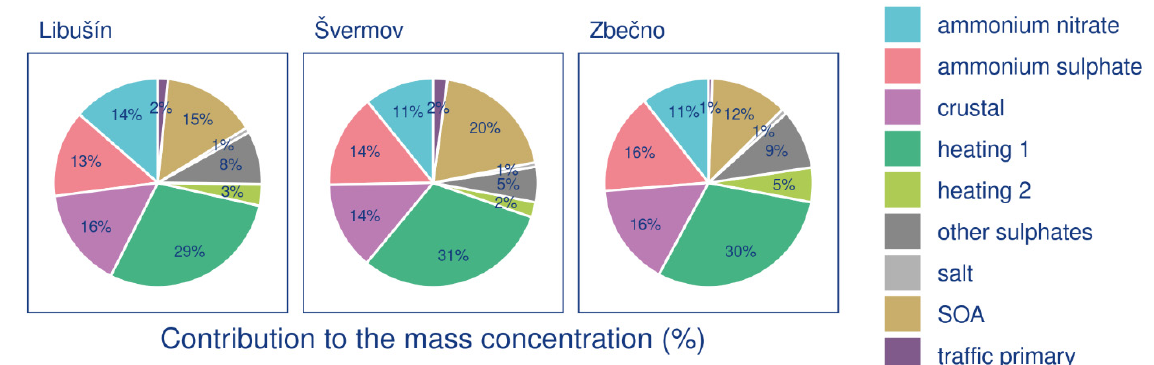
Figure 5. Relative factor contribution to the PM 2.5 mass grouped by monitoring sites.